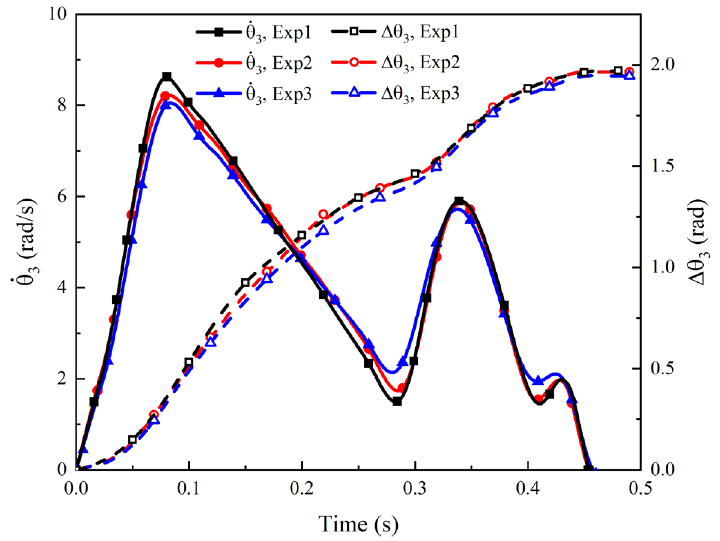
Figure 9. Time history curves of the deployment angle and angular velocity.